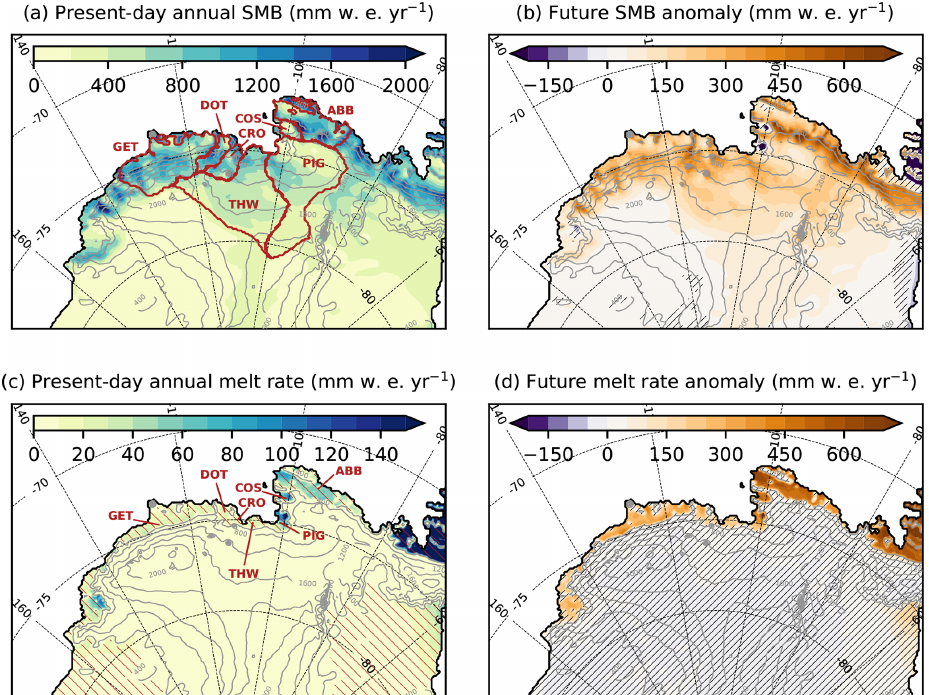
Figure 3. (a) Present-day annual mean SMB and (b) annual mean SMB anomaly (future minus present). (c) Present-day annual mean melt rate and (d) annual mean melt-rate anomaly (future minus present). The dark red contours in (a) indicate individual glacial drainage basins: Getz (GET), Dotson (DOT), Crosson (CRO), Thwaites (THW), Pine Island Glacier (PIG), Cosgrove (COS), and Abbot (ABB). Red hatching in (c) indicates ice shelves. Black narrow hatching in panels (b, d) indicate areas where the difference is not statistically significant ( t test on annual means with a p value of 0.05). The ice-sheet topography is shown in grey (contours every